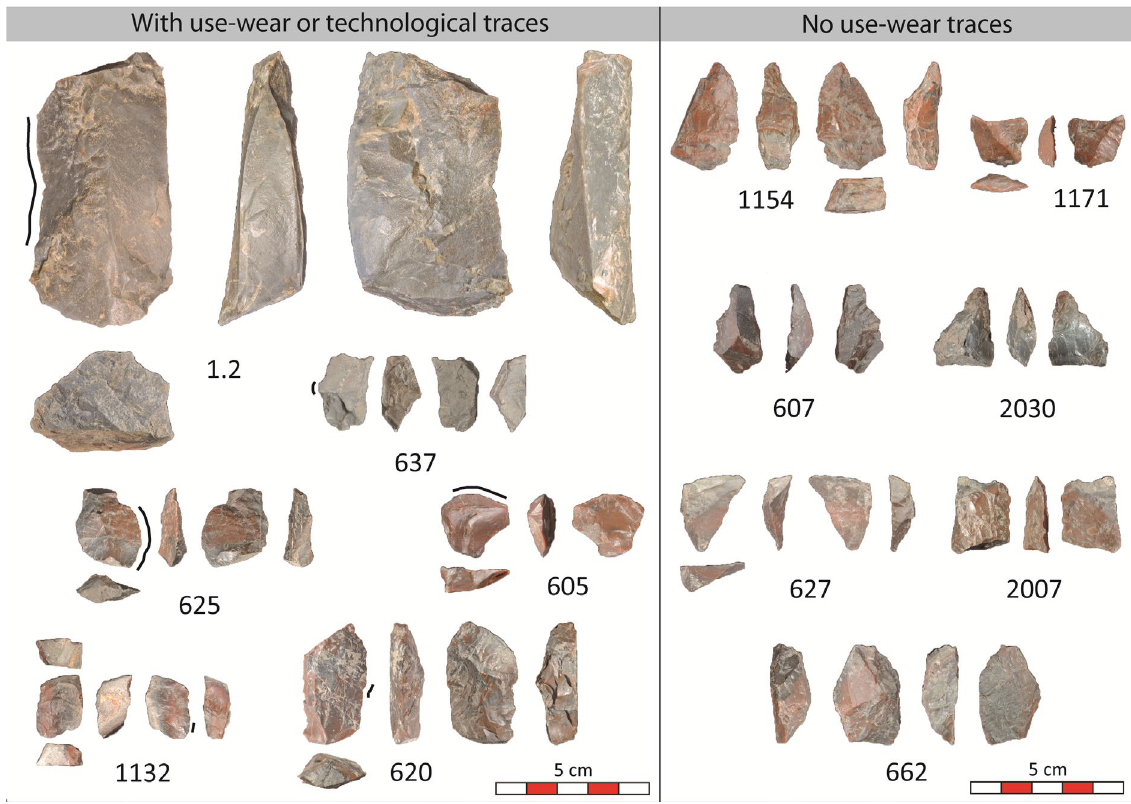
Figure 4. Lithics studied for use-wear analysis and localization of the active area (white line). 1.2: used to process hard material in a longitudinal motion; 620: used in a longitudinal motion possibly for butchering activities; 625: used in a longitudinal motion for butchering activities; 605: used to process plant in a transversal unidirectional motion; 637: bears technological traces, or to work a semi hard material in a transversal bidirectional motion; and 1132: technological traces. The remaining specimens, in the right half of the figure, do not have use-wear or technological